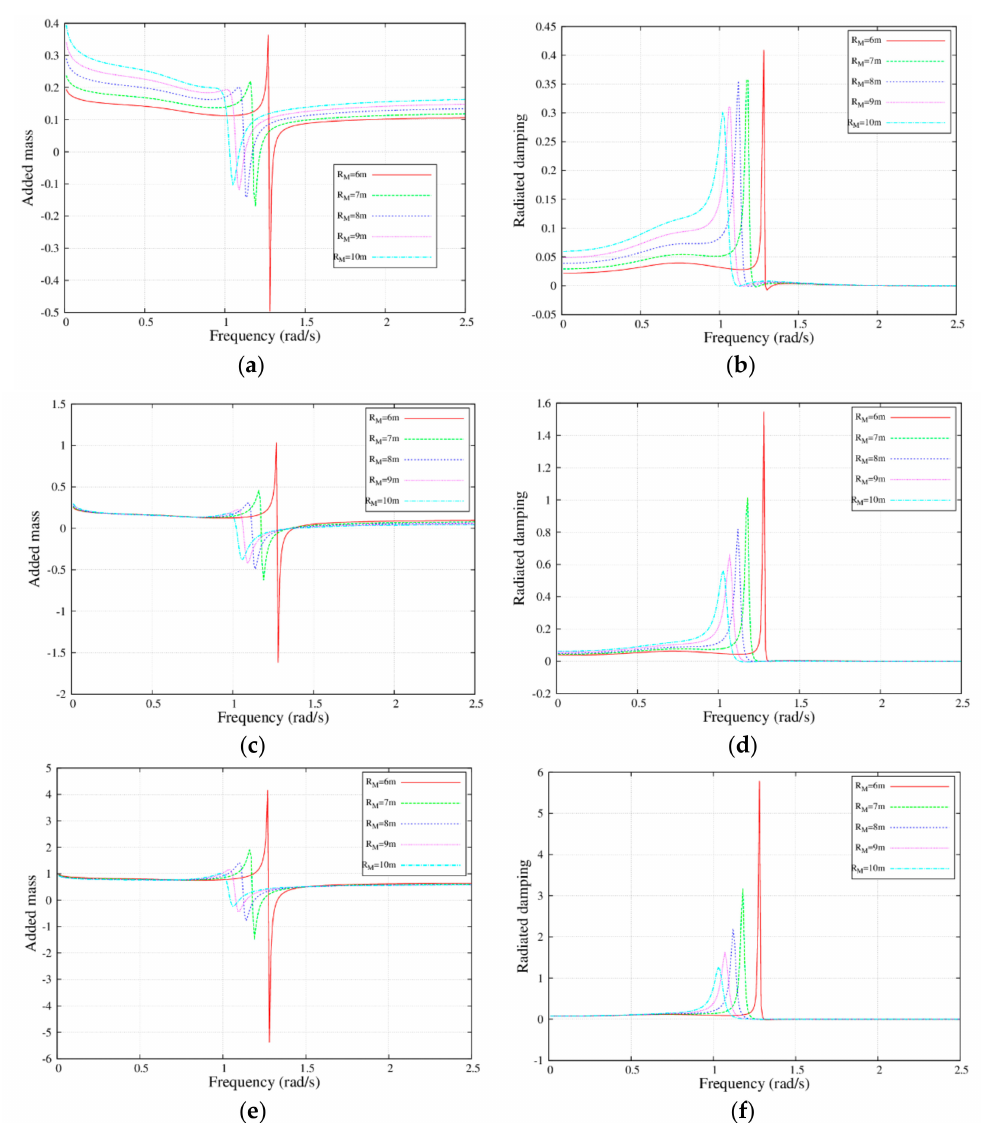
Figure 5. Added mass and damping coe ffi cients with the frequency for MM (MP to MP), MB (MP to WEB or WEB to MP), and BB (WEB to WEB) with di ff erent draft; R M = 6, 7, 8, 9, and 10 m. ( a ) µ , d M = 6 m; ( b ) λ MM , d M = 6 m; ( c ) µ MM